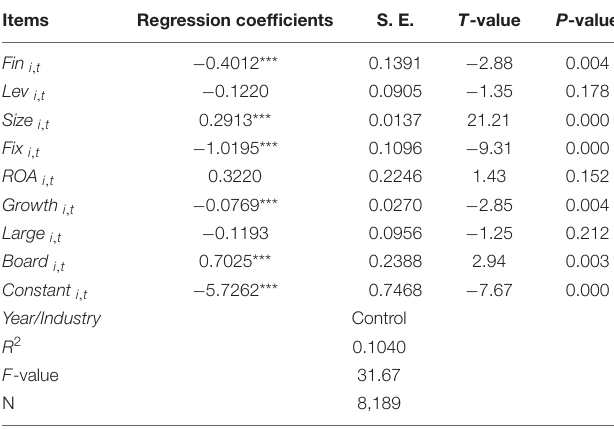
TABLE 4 | Regression results of financialization and the enterprise’s